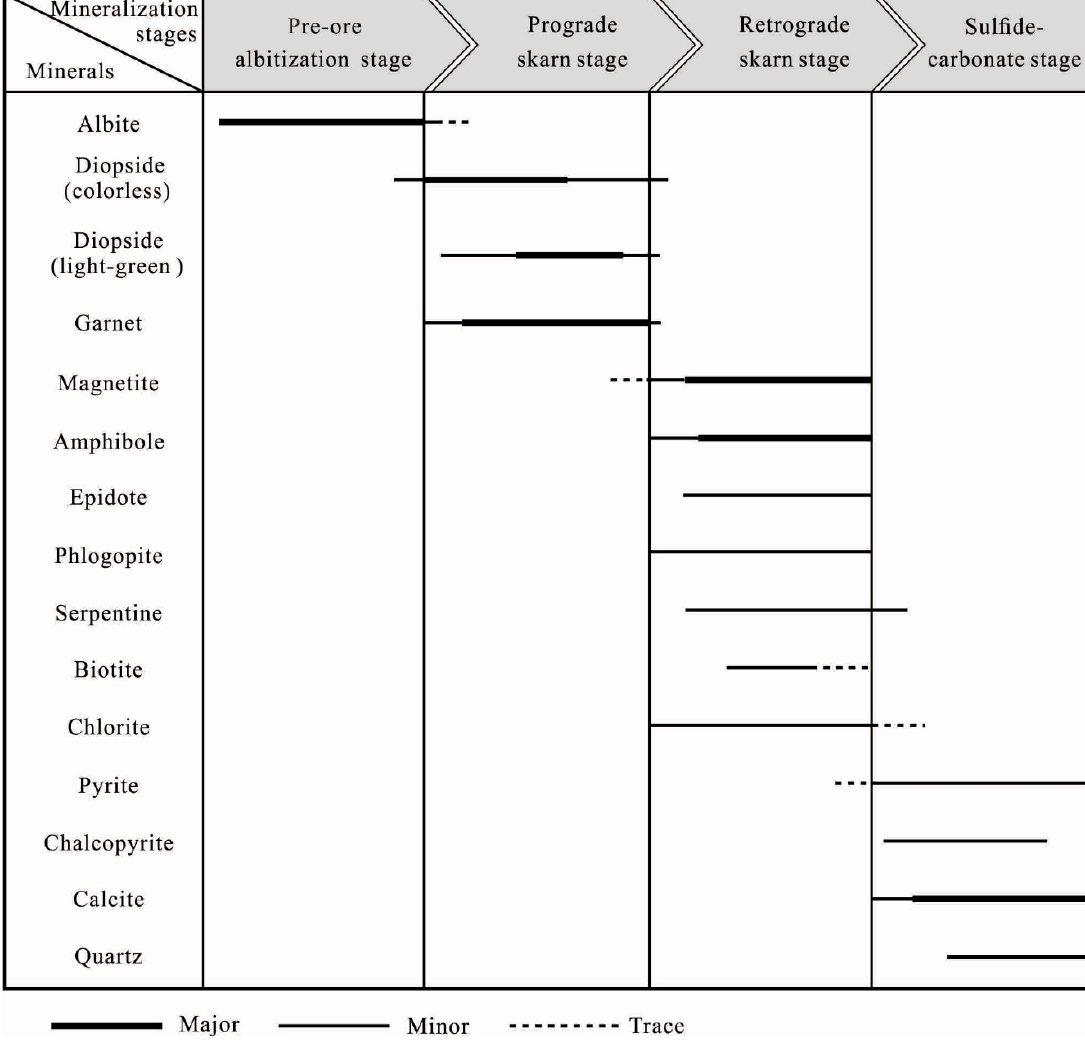
Figure 8. Mineral paragenesis for the Jinling iron skarn deposit.